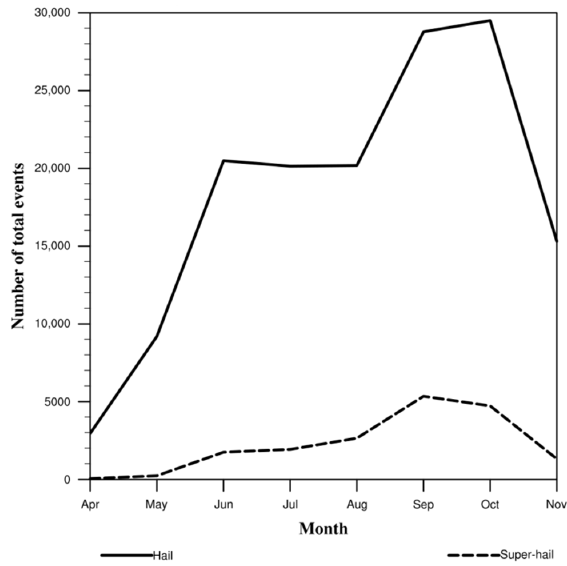
Figure 4. Monthly distributions of hail (solid line) and super-hail (dashed line) events occurred in the Mediterranean basin in the period April-November from 1999 to 2021.